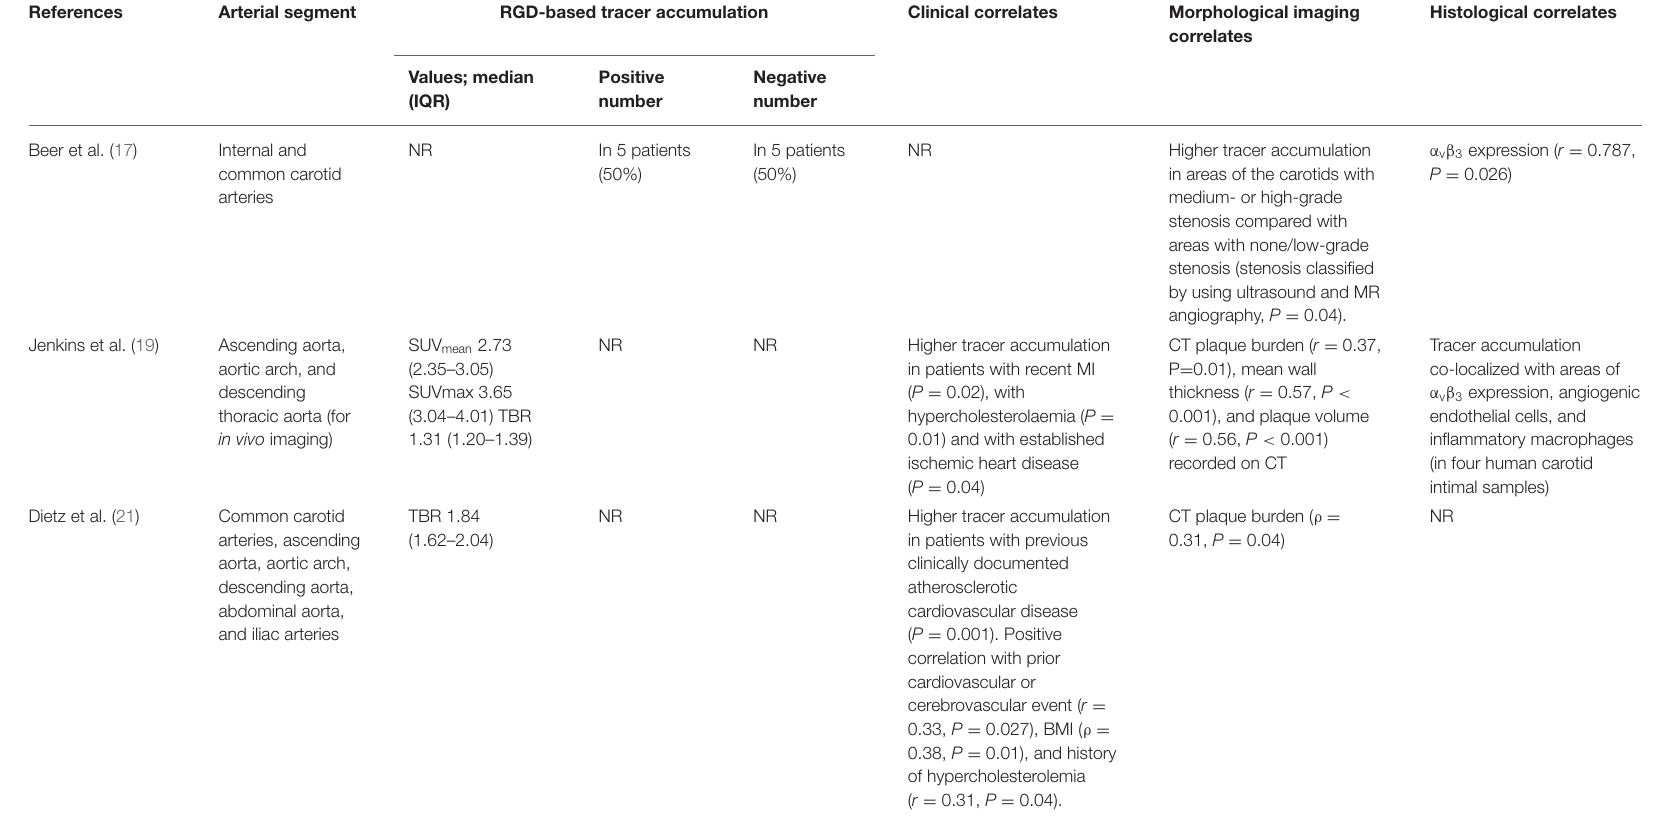
TABLE 4 | Summary of PET findings for studies focused on